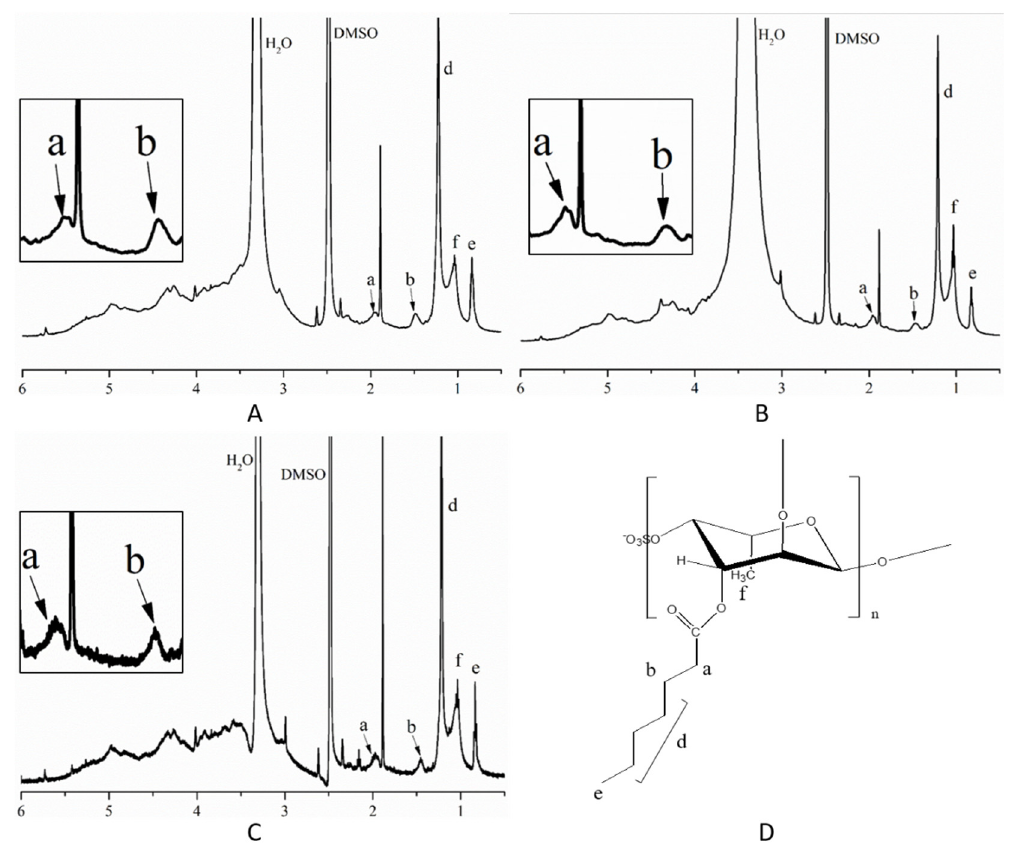
Figure 3. 1 H-NMR spectra of the SFP long-chain alkyl group derivatives (d = 9, 11, 13). ( A ) 1 H-NMR spectra of SFP-C12; ( B ) 1 H-NMR spectra of SFP-C14; ( C ) 1 H-NMR spectra of C16; ( D ) The chemical structures of SFP long-chain alkyl group derivatives. The peaks a, b, c, d, e in ( A – C ) represent different proton absorption and they are indicated in ( D ).